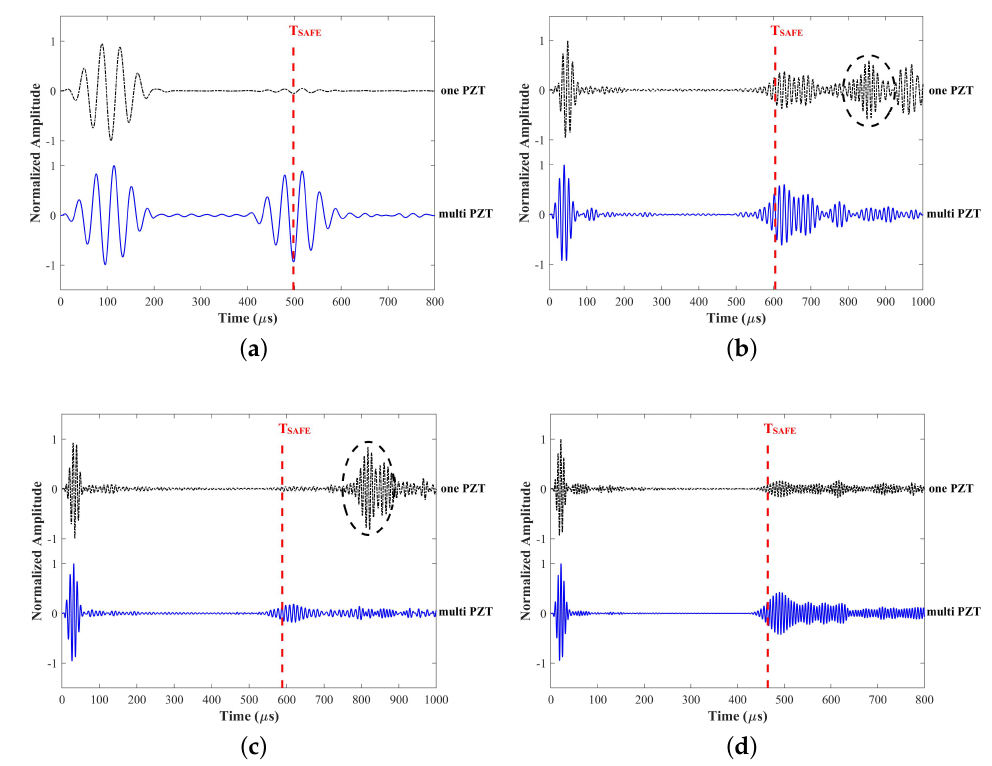
Figure 13. Time-domain ultrasonic guided wave signals in FE via only one PZT and weighted gathering at: ( a ) 25 kHz M4, ( b ) 80 kHz M9, ( c ) 100 kHz M11, ( d ) 155 kHz